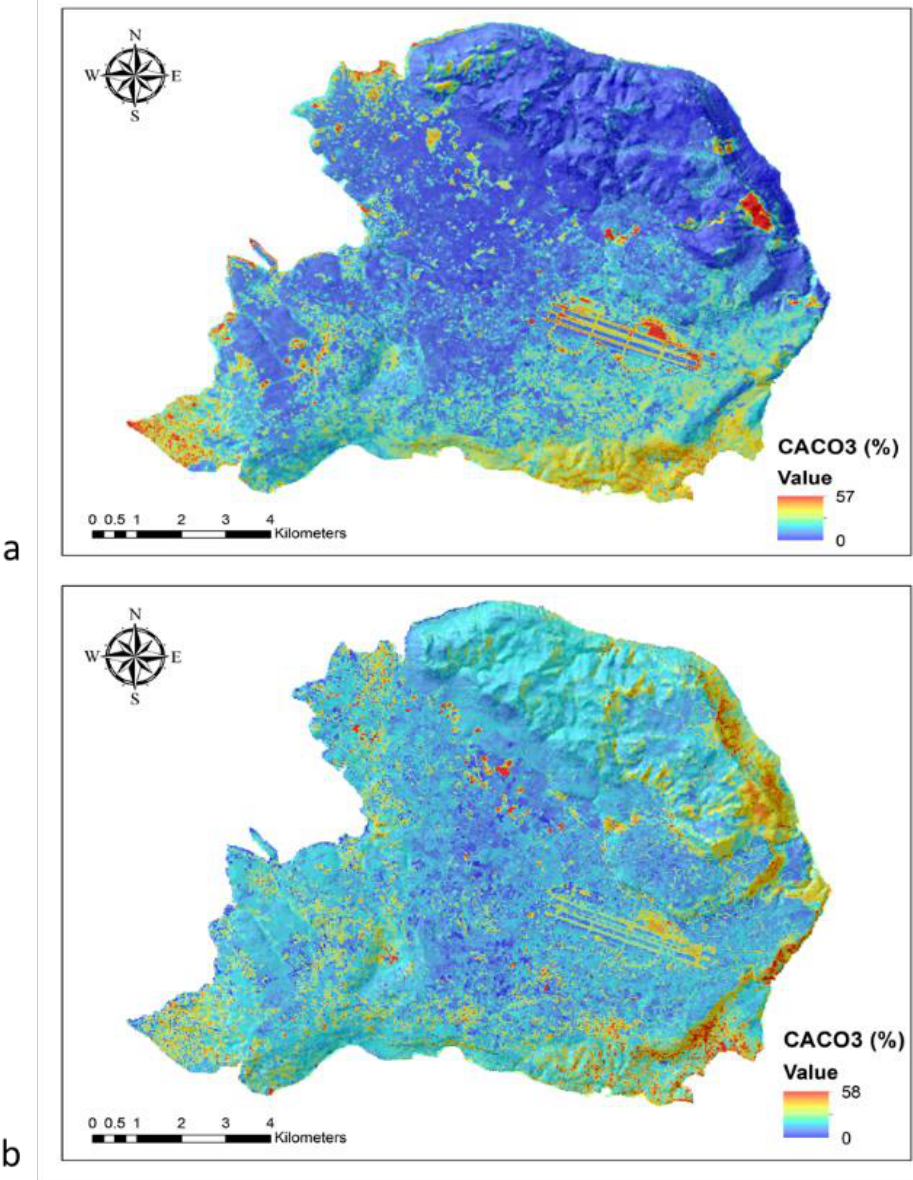
Figure 8. Spatial distribution of CaCO 3 as estimated from the integrated use of ANN and Landsat 8 ( a ), and Sentinel-2 ( b ) imageries.